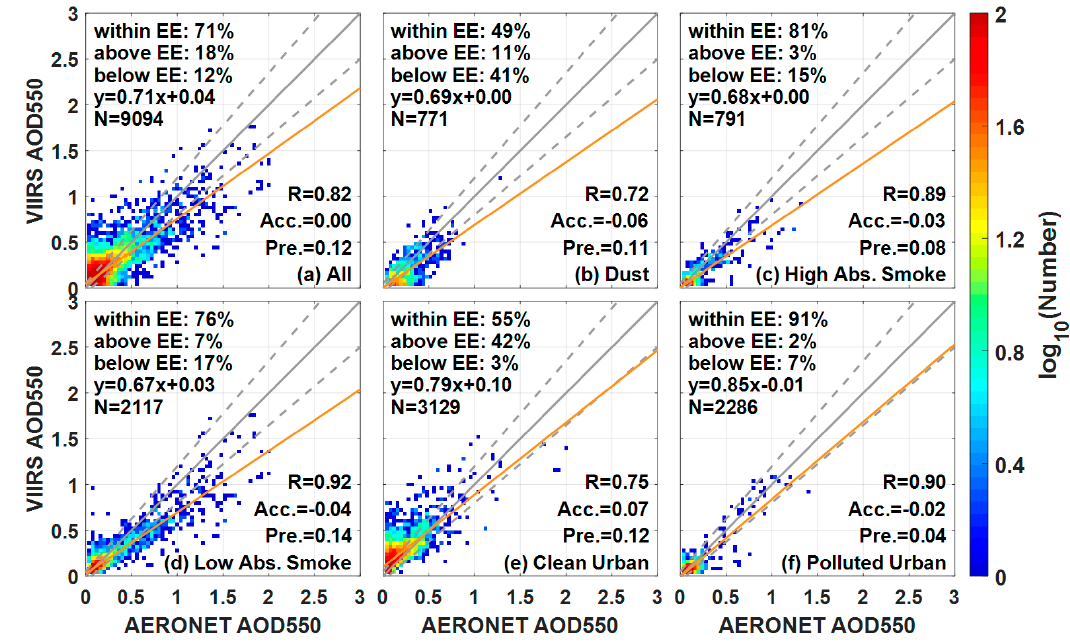
Figure 7. VIIRS aerosol retrievals and AERONET measurements agree on the aerosol type. The scatterplots of the VIIRS AODs against AERONET measurements under different VIIRS aerosol types: ( a ) All; ( b ) dust; ( c ) High Absorption Smoke; ( d ) Low Absorption Smoke; ( e ) Clean Urban and ( f ) Polluted Urban. The width of each pixel is 0.04, and the number of collocations that falls within/above/below EE is represented in each figure. The yellow line is the regression line, the gray solid line is the 1:1 line, and the gray dashed lines are the EE envelopes.